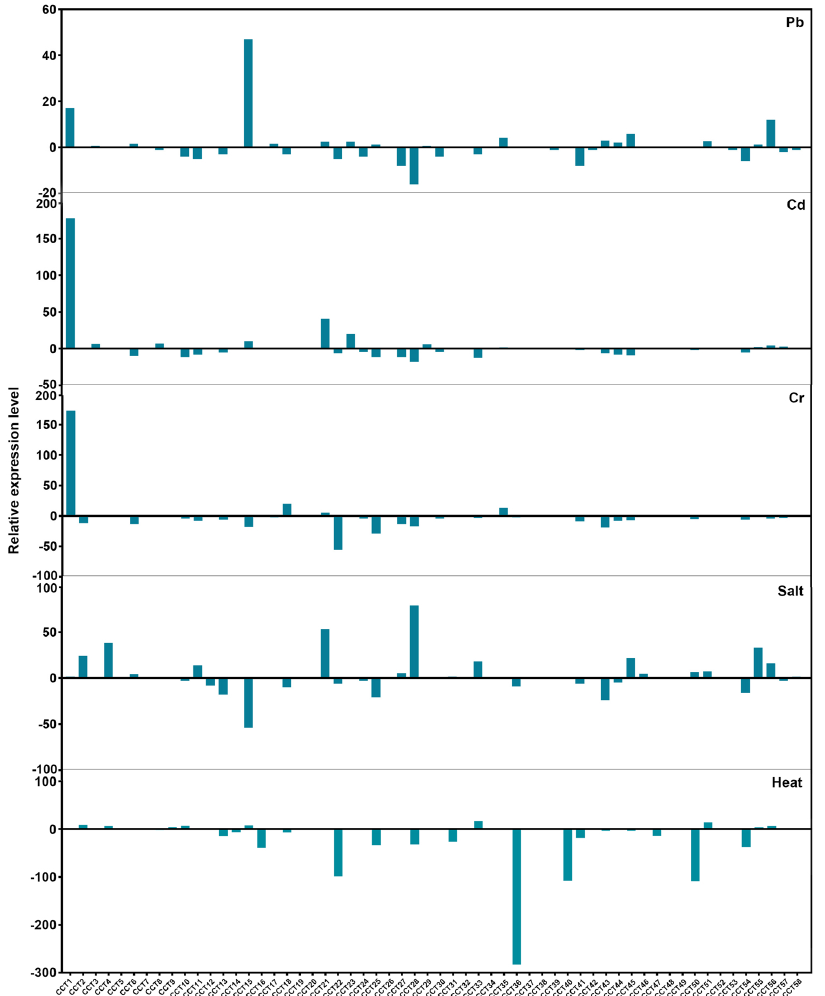
Figure 9. Expression profiles of RsCCT genes under Pb, Cd, Cr, and salt and heat stresses, obtained from RNA-seq data. The expression level of the RsCCT gene was standardized with log2 (FPKM +